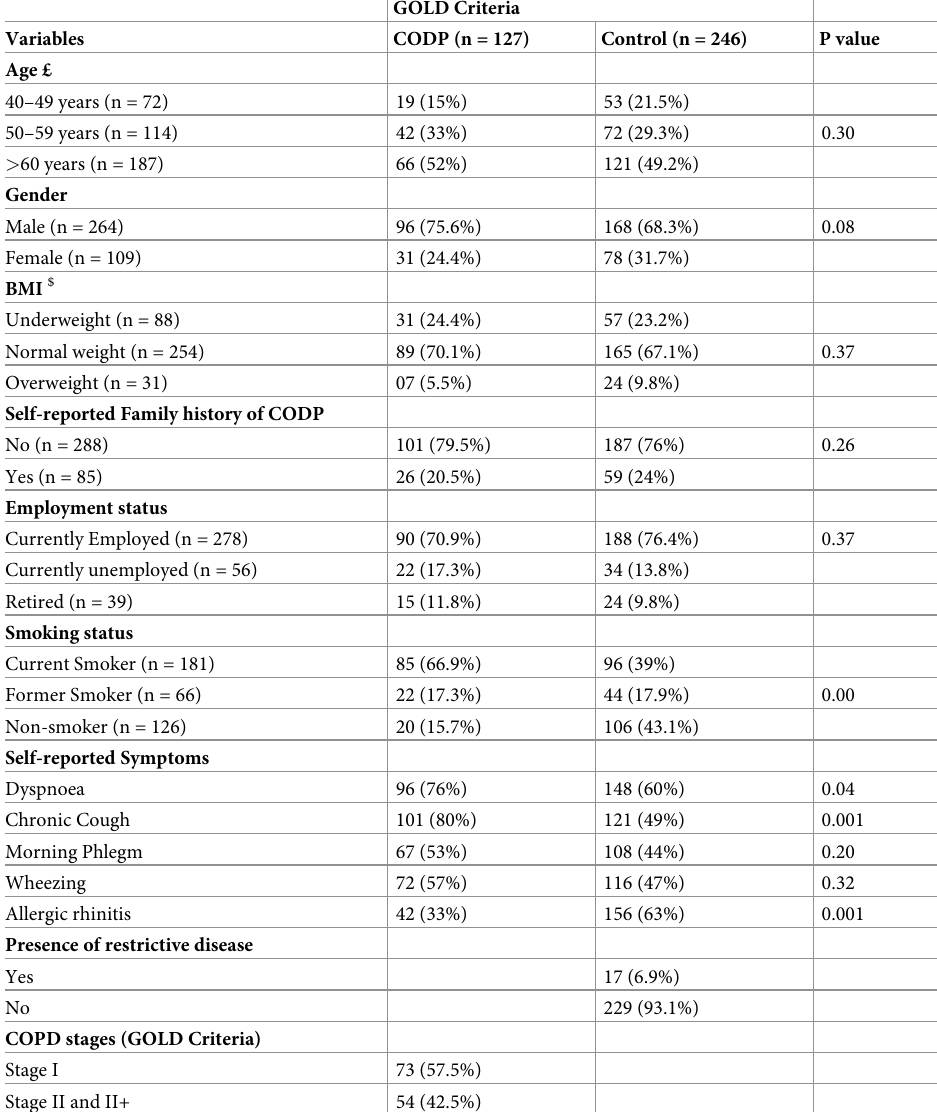
Table 1. Demographic and health characteristics of the